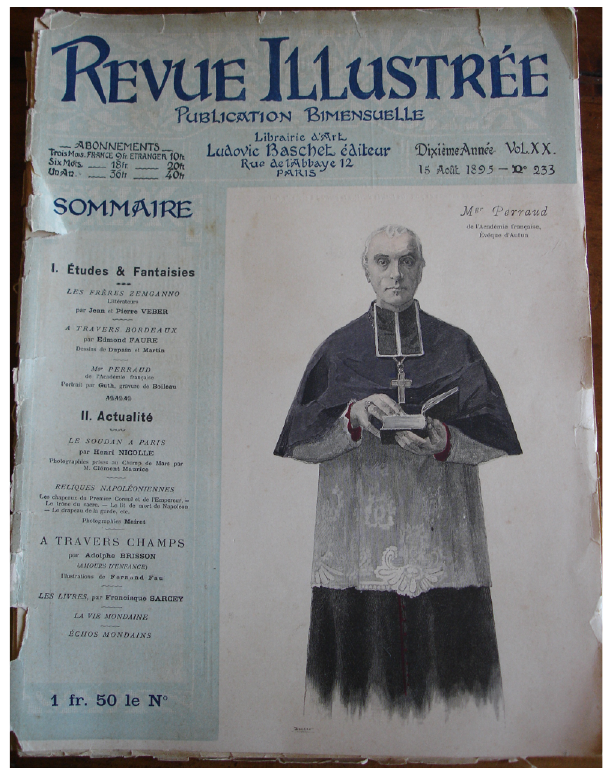
Fig. 1 Revue illustrée , no. 233 (15 August 1895), front cover. Mgr. Perraud, member of the Académie Française, Bishop of Autun. Private